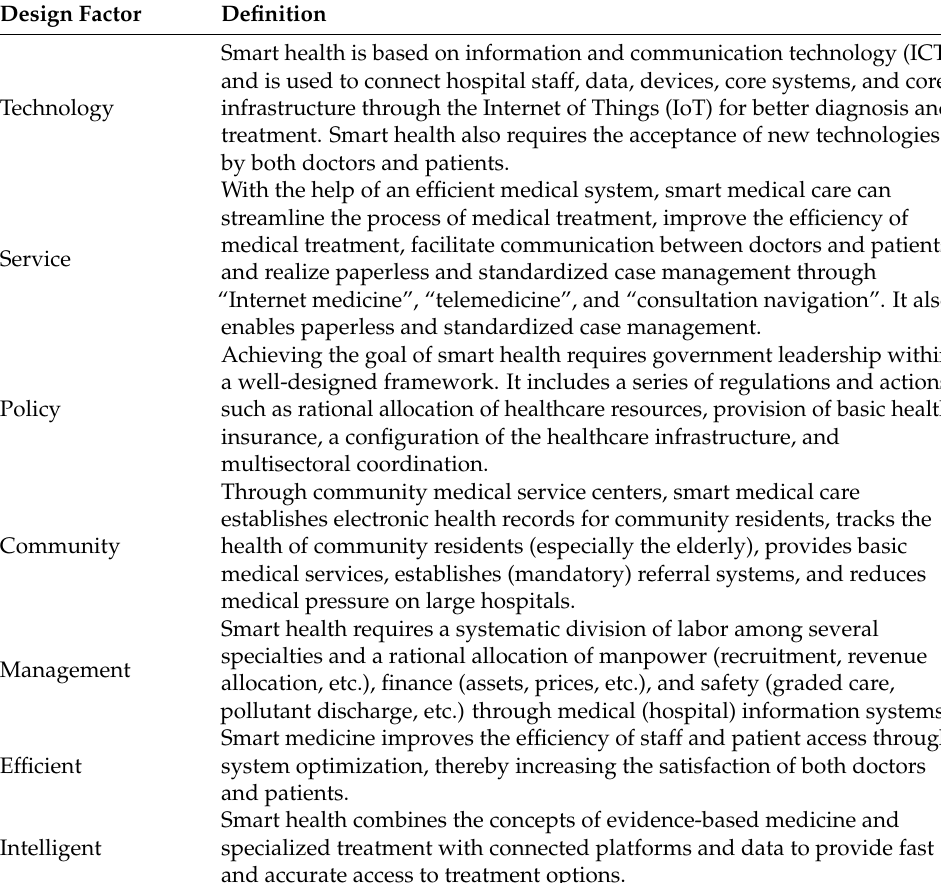
Table 1. Smart health factors and